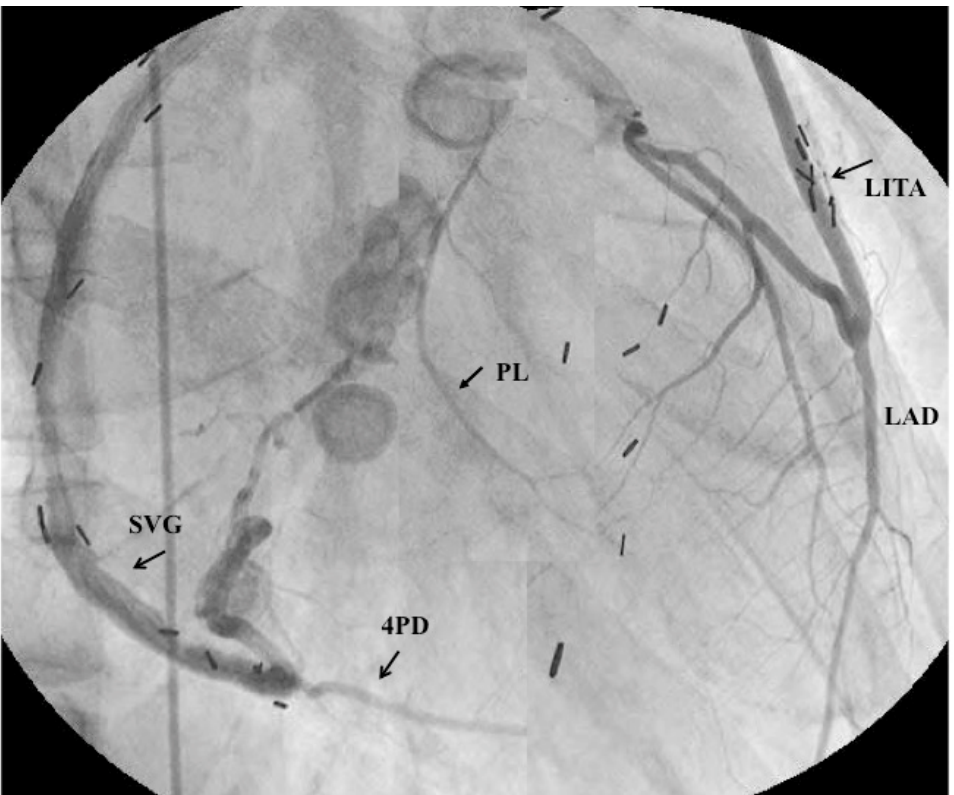
Figure 5. Selective angiograms 34 years after coronary-artery bypass grafting (CABG). This male patient had surgery at the age of six years old. The saphenous vein graft and internal thoracic-artery graft demonstrated patency. Both the left main coronary artery and the right coronary orifice were asymptomatically occluded during the late period after the surgery (this was the first case to use an ITA in a child) [26].